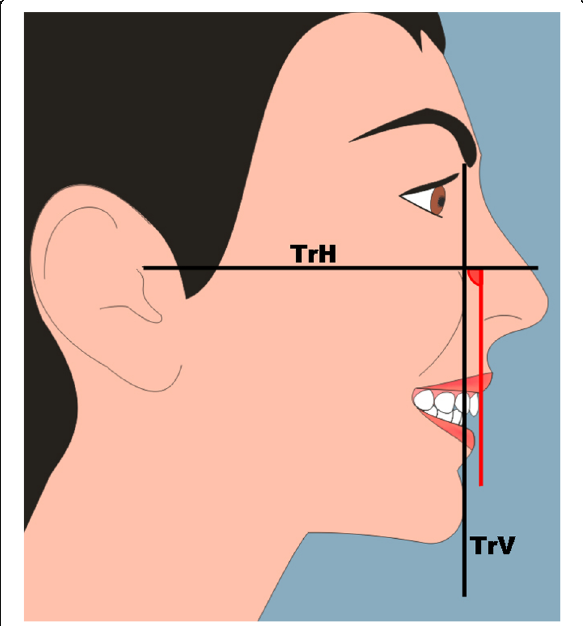
Fig. 2 Female smiling profile view; TrH, true horizontal line; TrV, true vertical line; red vertical line is the tangent to the labial face of the maxillary central incisor crown, and the measured angle is the inclination of the labial face tangent in relation to the TrH line